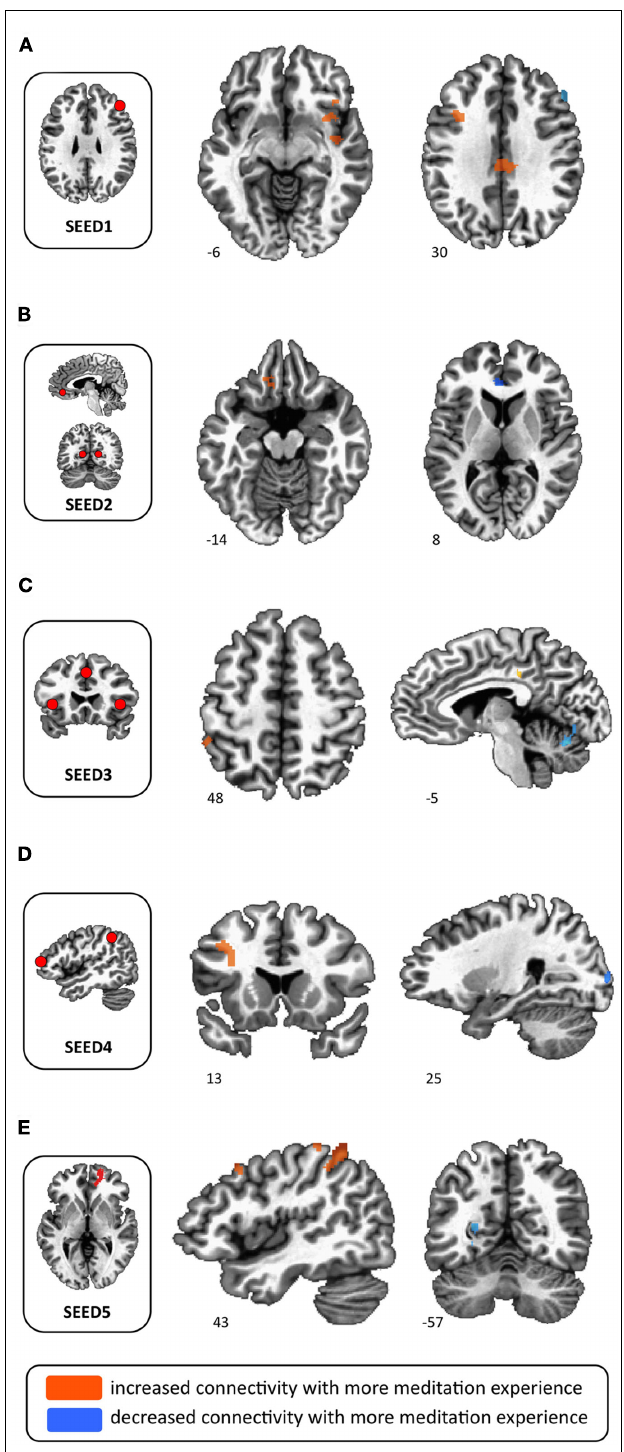
FIGURE 2 | Functional connectivity differences between high and low practice participants. (A) Increased functional connectivity in high practice participants between SEED1 and right insula, left dlPFC, and mid-cingulate. (B) Increased functional connectivity in high practice participants between SEED2 and left orbitofrontal cortex; decreased functional connectivity in